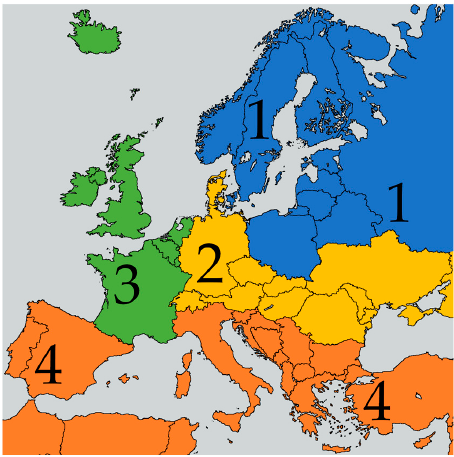
Figure 6. Practical climate zoning for Climate for Culture outcomes evaluation [57] (1-Northern climate, 2-Eastern-Continental climate, Western-Island climate, Southern climate).